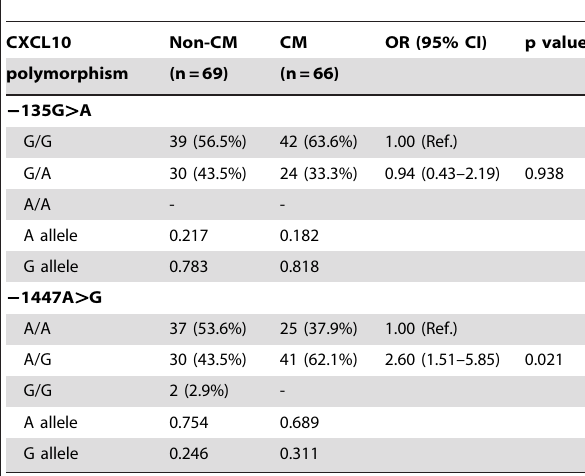
Table 2. Genotype and allele frequency of CXCL10 polymorphisms in patients with cerebral malaria and non- cerebral malaria.